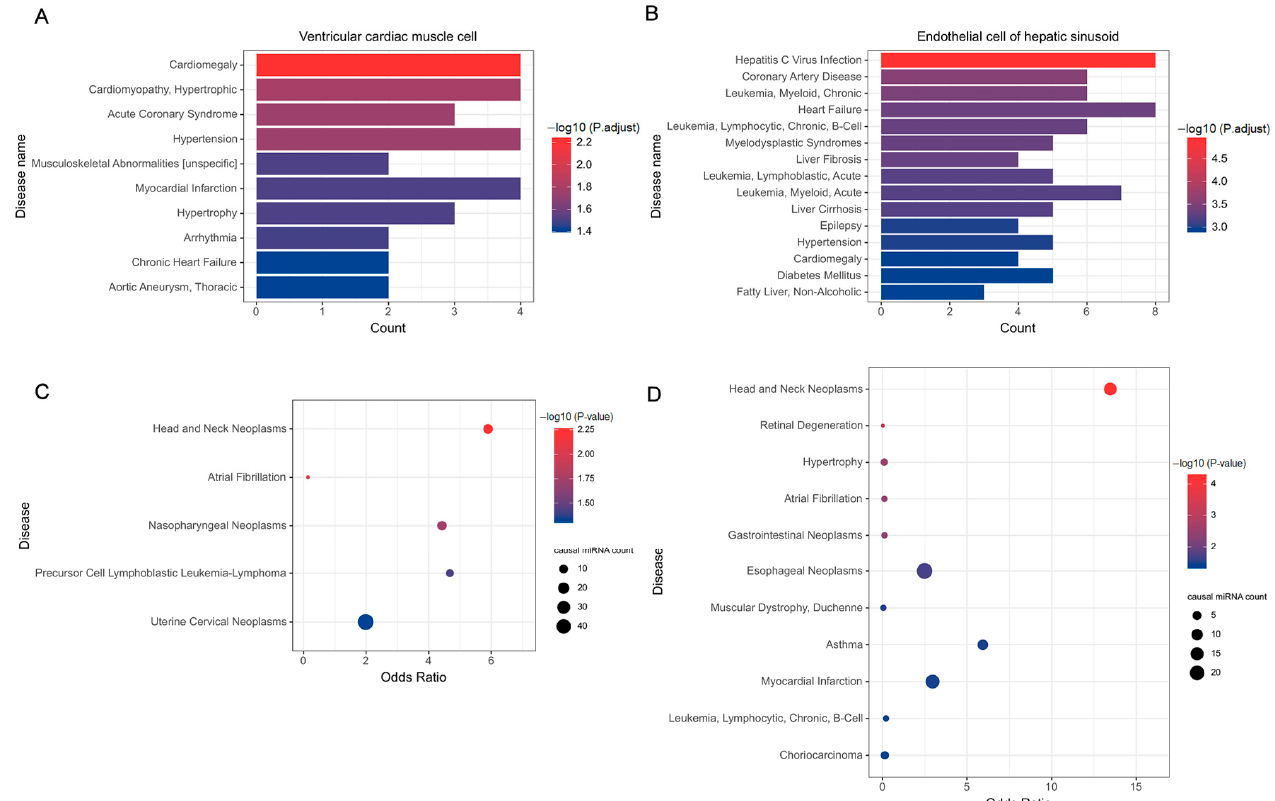
Figure 3. Association of cell-type-specific miRNAs with disease miRNAs. ( A ) Disease association enrichment analysis results of chromatin activity-specific miRNAs in ventricular cardiac muscle cells. ( B ) Disease association enrichment analysis results of expression-specific miRNAs in endothelial cells of the liver sinusoids. ( C ) Associations of cell type chromatin activity-specific miRNAs with disease causal miRNAs. ( D ) Associations of cell type expression-specific miRNAs with disease causal miRNAs.